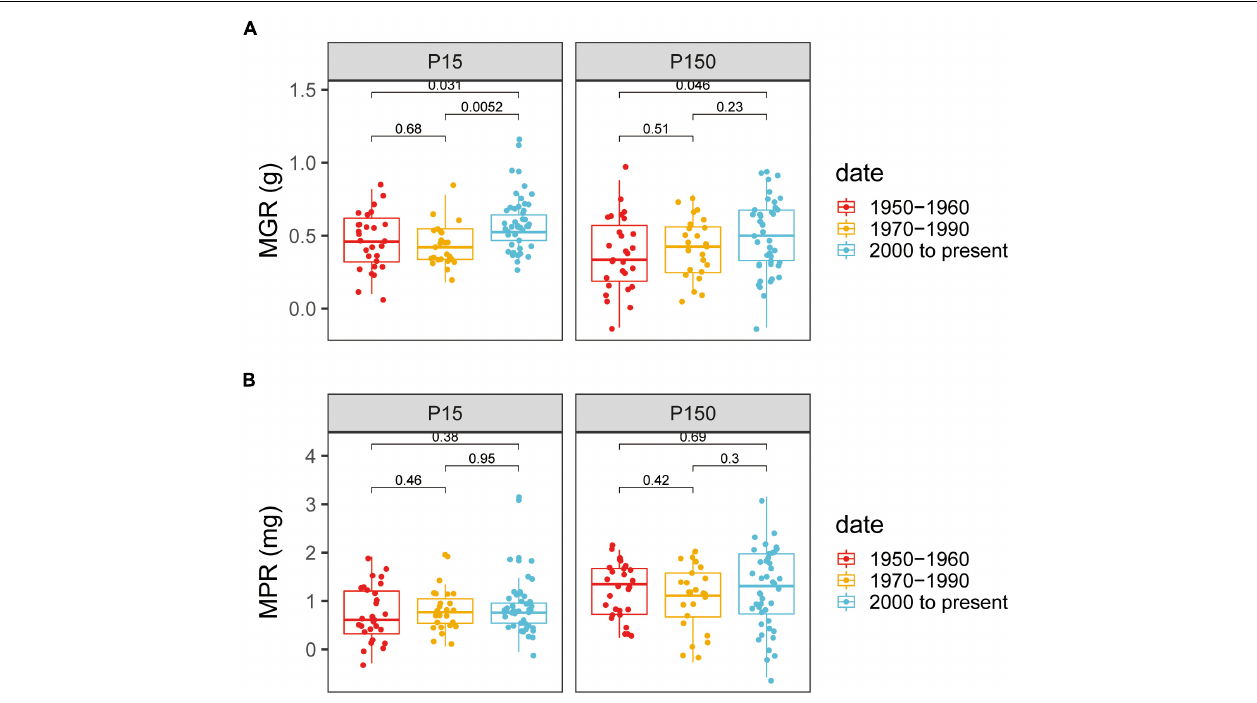
FIGURE 3 | Mycorrhizae-induced changes in shoot growth [mycorrhizal growth responsiveness (MGR)] and shoot P content [mycorrhizal P responsiveness (MPR)] for cotton varieties with different release dates under low (A) or high (B) P supply. The groups (and bar patterns) are as follows: 1950–1960 (red), 1970–1990 (yellow), and 2000 to present (blue). We defined those from “1950–1960” and “2000 to present” as the old and modern varieties, respectively. Boxes show the first quartile, median, and third quartile. Whiskers extend to the most extreme points within 1.5 × box length. The Wilcoxon signed-rank test was carried out between different groups and the p -value is